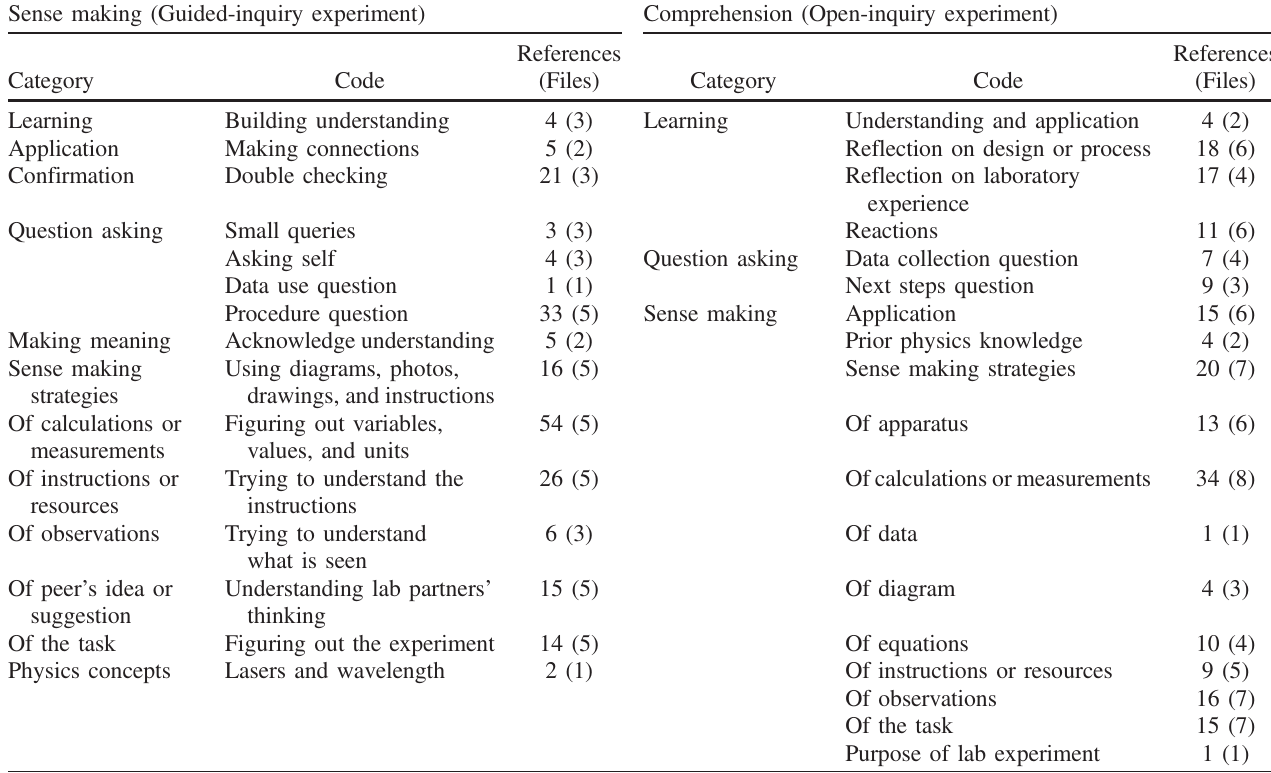
TABLE VIII. Open codes that are unique in the sense making theme in the guided-inquiry data set in comparison to the comprehension theme in the open-inquiry data set. The numbers shown in the table are how many times each code is referenced in the corresponding experiment and how many files each code is referenced (shown in parentheses). Note that there are a total of 5 guided- inquiry files and 8 open-inquiry files.